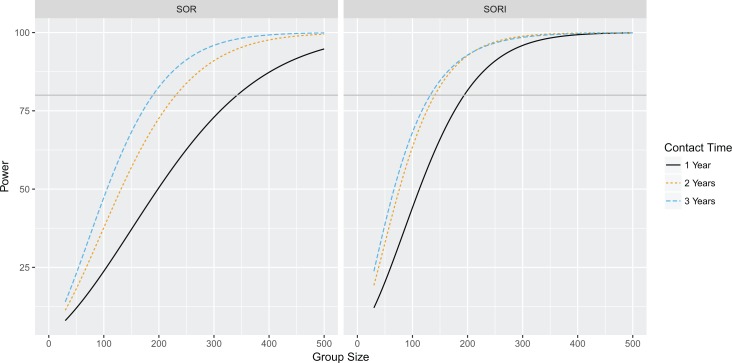
Power to estimate 50% total vaccine efficacy for SOR and SORI parameter estimates for contact times of 1, 2 and 3 years Statistical power as a function of group size to estimate a significant difference in vaccinated and unvaccinated groups at the 95% level for an effect size of 50% total vaccine efficacy based upon SOR and SORI parameter estimates.Grey line indicates the 80% power level.